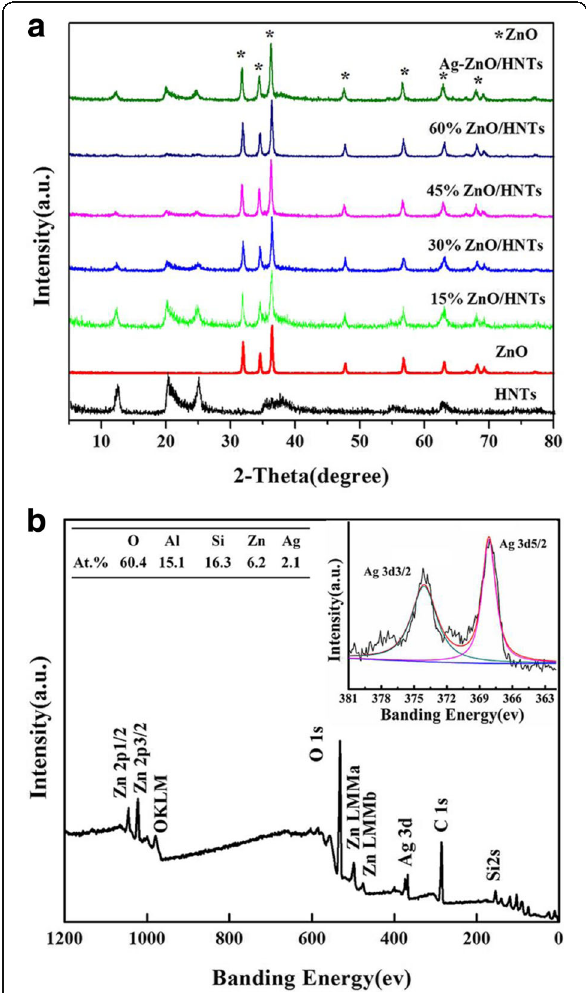
Fig. 1 a XRD patterns of HNTs, ZnO, ZnO/HNTs with different ZnO loading, and Ag-ZnO/HNTs and b XPS spectra of Ag-ZnO/HNTs and atomic concentrations of different elements for